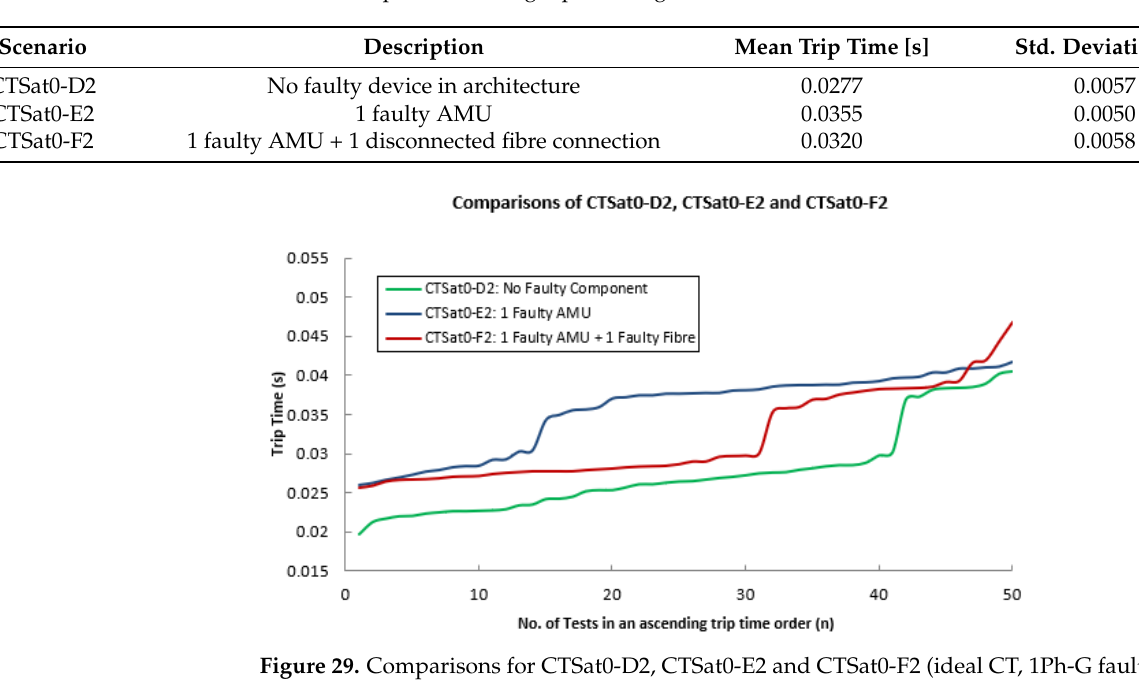
Table 10. Trip times for single-phase-to-ground fault.